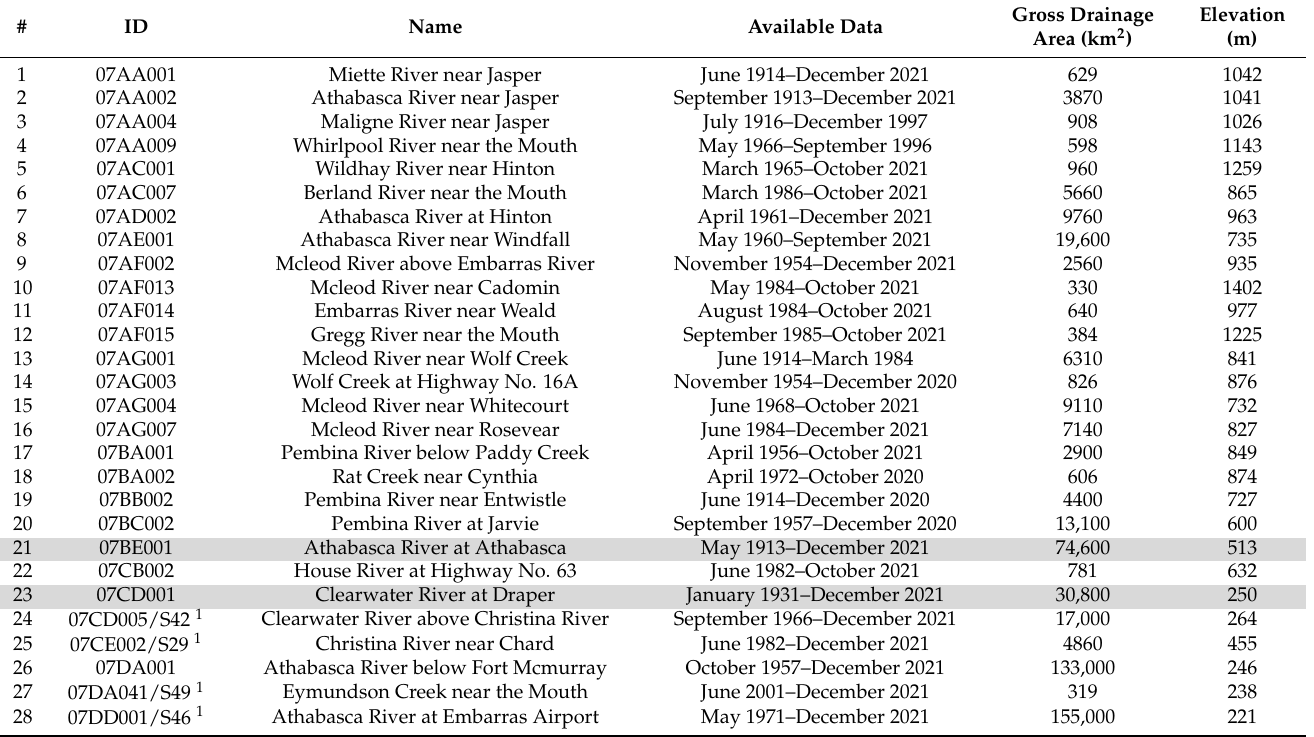
Table 1. A list of hydrometric stations utilized in this study. Stations with continuous monthly stream- flow data from 1960 to 2022 are highlighted in gray to indicate their completeness. The IDs we have assigned to each hydrometric station in the maps used in this article are indicated by the symbol